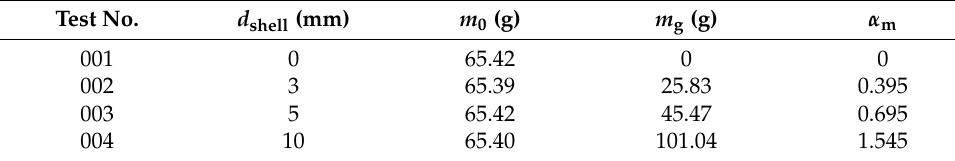
Table 3. Experimental schemes and mass ratio of the charge for the tests. Test